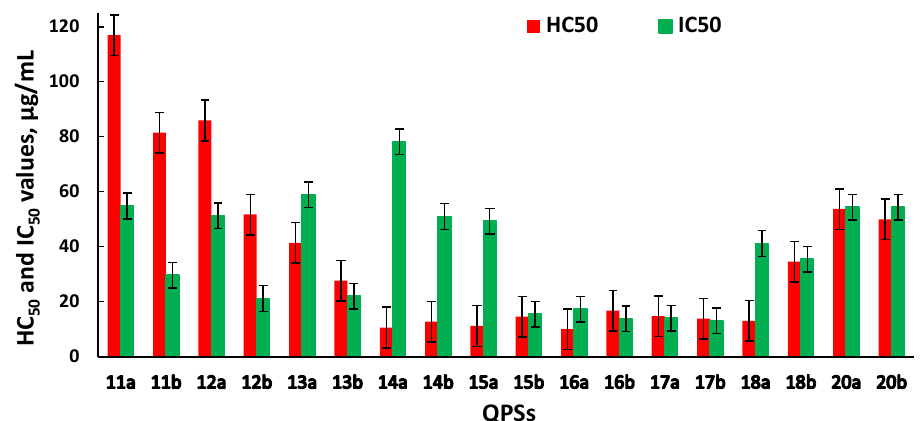
Figure 1. Hemotoxic and cytotoxic activity of QPSs, expressed in terms of HC 50 and IC 50 . Data on hemolytic and cytotoxic activity are represented by the HC 50 (the concentra- tion of the test compound that causes the 50% hemolysis of erythrocytes in the experiment) and IC 50 (the concentration of the test compound that causes the death of 50% of the cells in the test population) values, respectively.